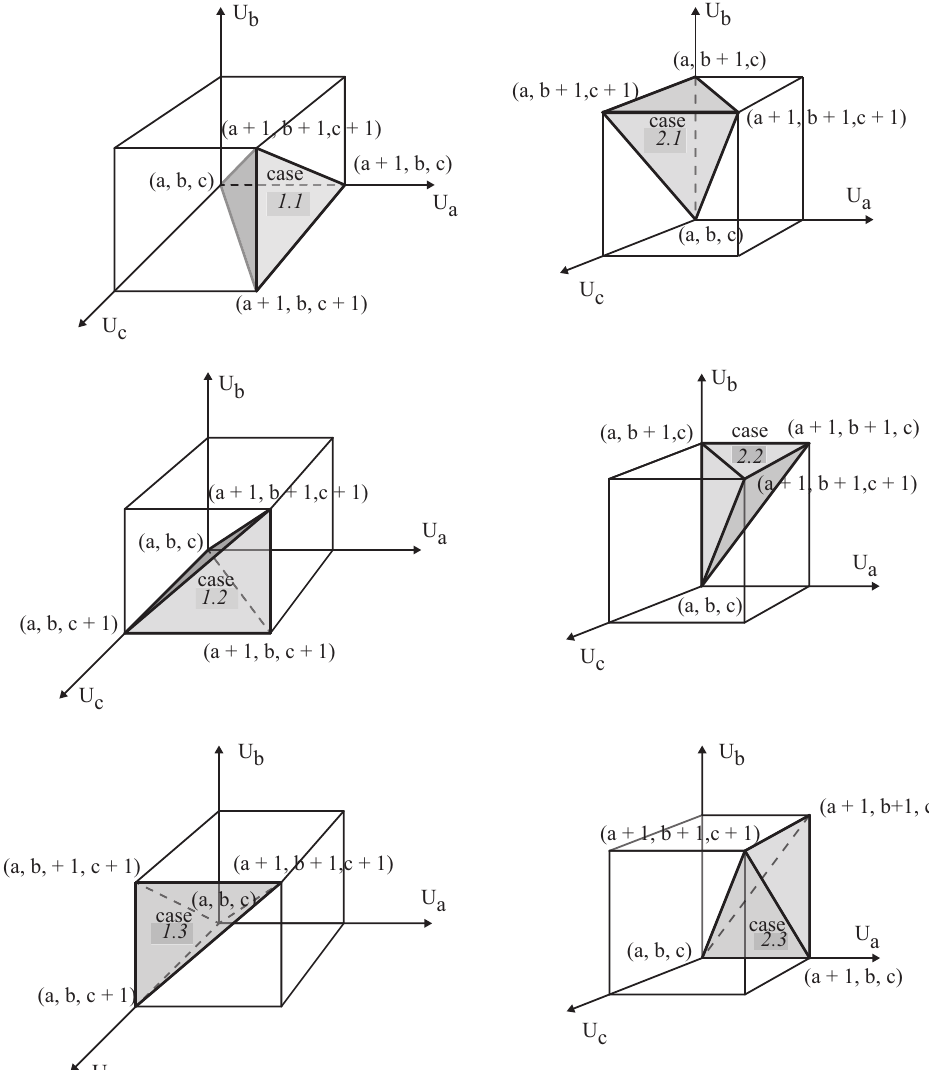
Figure 13. Tetrahedrons in a sub-cube with corresponding state